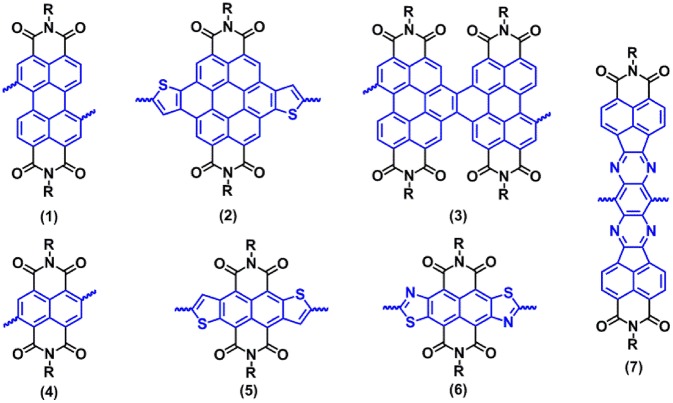
Some perylene diimide and naphthalene diimide building blocks in conjugated polymers.